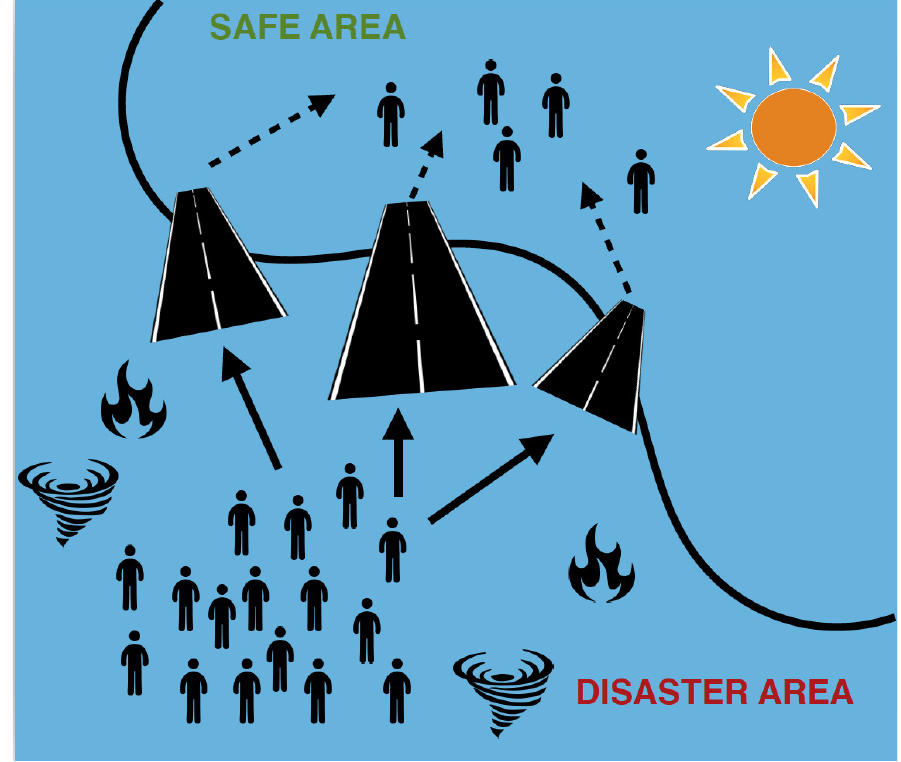
Figure 1. Topology of the disaster area and system